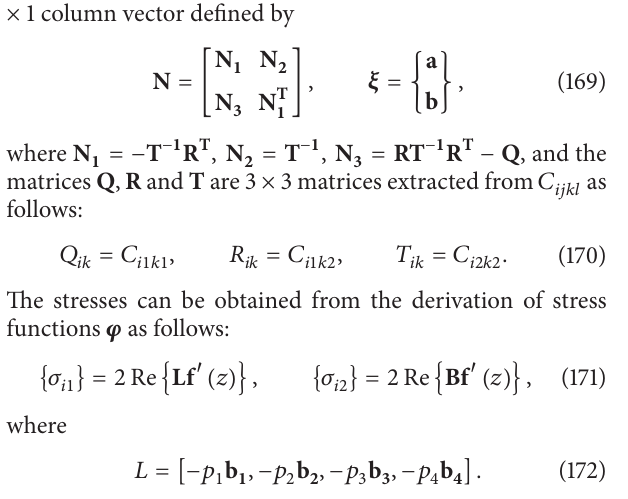
Figure 7: Schematic of the relationship between global coordinate system ( 𝑥 1 ,𝑥 2 ) and local material coordinate system ( 𝑥,𝑦